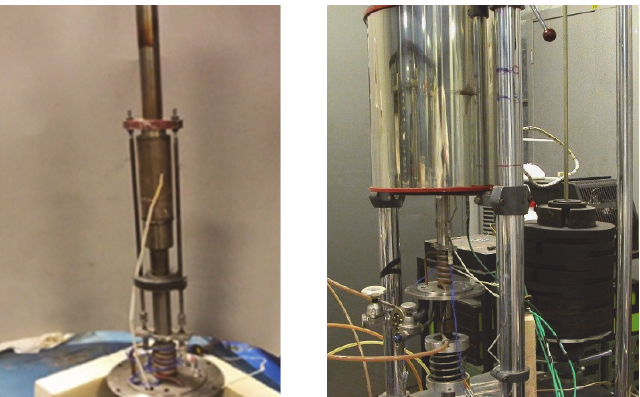
Figure 3: Cell assembly, designed and manufactured for tests in lead, on a MAYES machine during the specimen fixing and with its